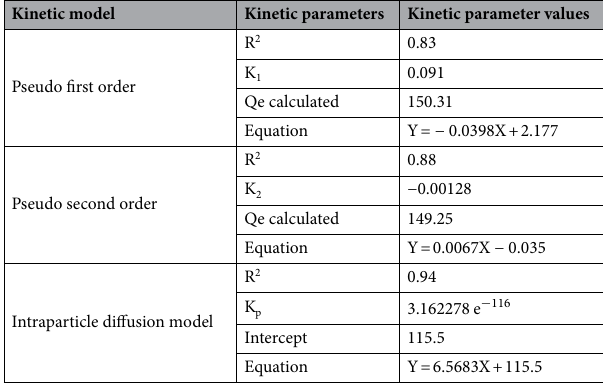
Table 5. Kinetics parameters for adsorption of MB onto Rumex abysiniccus activated